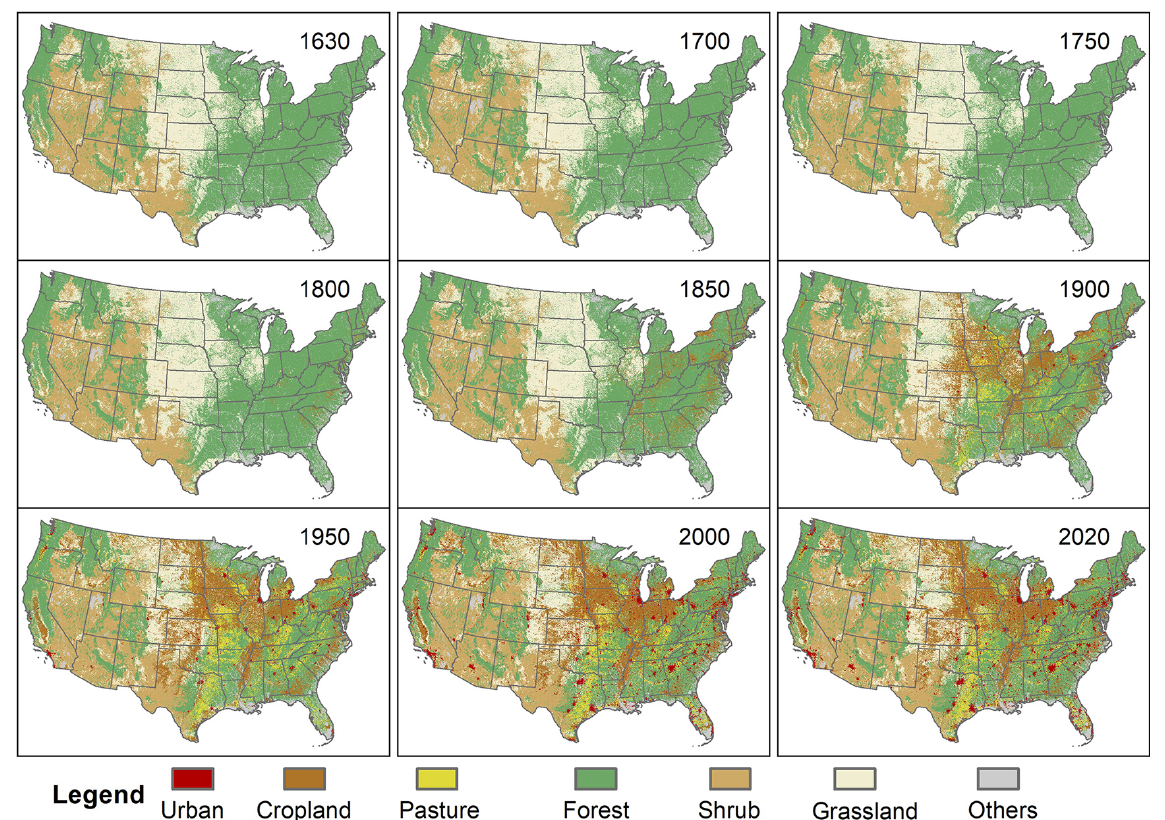
Figure 5. Spatiotemporal patterns of land use and land cover in the conterminous United States during 1630–2020.